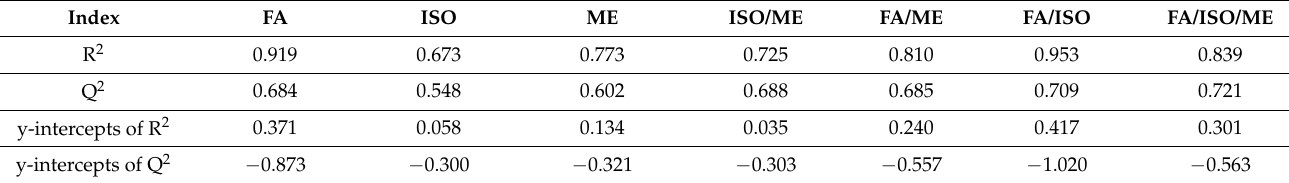
FA = Fatty acid; ISO = Isotope; ME = Mineral elements; R 2 = the measure of the fit of the model; Q 2 = the measure of predictive ability of the model.